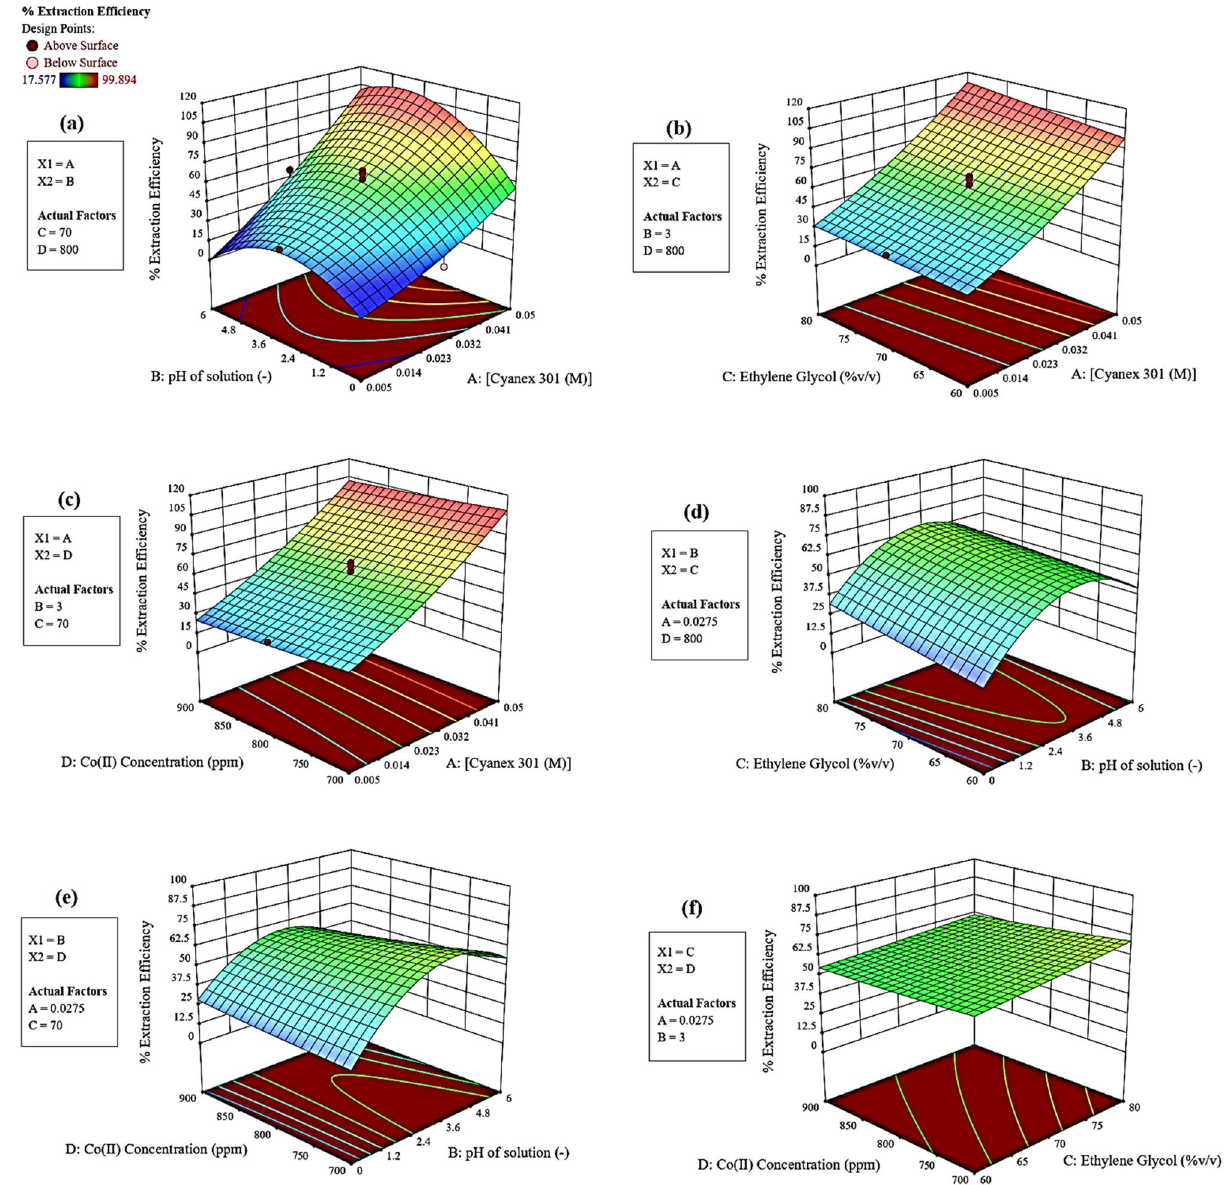
Figure 4. 3D plots for the description of each parameter on the Co(II) removal under non-aqueous system; ( a ) effect of pH and Cyanex301 concentration; ( b ) effect of ethylene glycol percent and Cyanex301 concentration; ( c ) effect of cobalt concentration and Cyanex301 concentration; ( d ) effect of ethylene glycol percent and pH; ( e ) effect of cobalt concentration and pH; ( f ) effect of cobalt concentration and ethylene glycol Figure 5a,b,c,d showed the FT-IR spectra of pure ethylene glycol, pure Cyanex301, Cyanex301 + Co(II) from 100% aqueous phase, and Cyanex301 + Co(II) from 20% aqueous phase, 80% ethylene glycol, respectively. Char- acteristic vibrational bands from FTIR analysis is shown in Table 5. The S–H stretching peak of Cyanex301 is at 2378.97 cm −1 in Fig. 5b and disappears both in Fig. 5c,d because of the Cyanex301 − Co(II) complex formation. It indicates the replacement of the hydrogen in S–H by the metal ions. The absorption peak of P = S at 611.83 cm −1 in Fig. 5b shifts to 723.96 cm −1 in Fig. 5c,d,showing that there is a strong coordination effect between the P = S bond in Cyanex301 and the cobalt ions. The comparison of the organic phases in Fig. 5c,d showed the behavior of extraction in the non-aqueous system is similar to the aqueous system. At 2925 and 2957 cm −1 , C–H traction bands are also visible. Because of the presence of CH 3 group on the carbon atom. In EG spectrum (Fig. 5a), the OH group can be found around 3368 cm -1 . The CH 2 group vibration mode appears at 883 cm −1 . The bands at 1042 and 1086 cm −1 , respectively, indicate C–O and C–C stretching vibrations. Effect of temperature. The effect of different temperatures (25, 35, 45, 55 and 65 °C) on cobalt extraction using Cyanex301 in kerosene in the optimum condition is shown in Fig. 6a. As can be seen, the increase in the